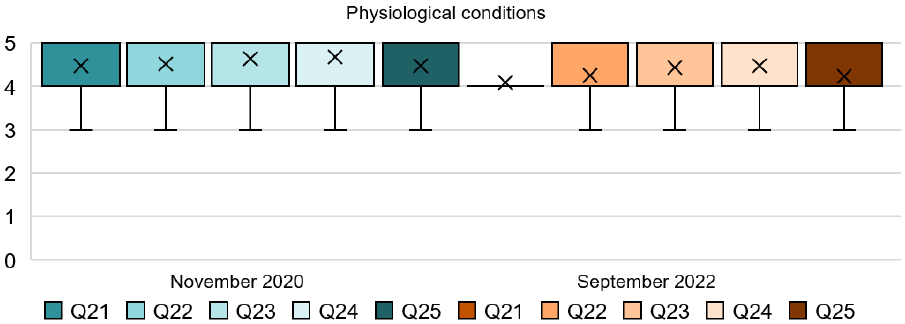
Figure 9. Interval data graph of the Physiological Conditions dimension.